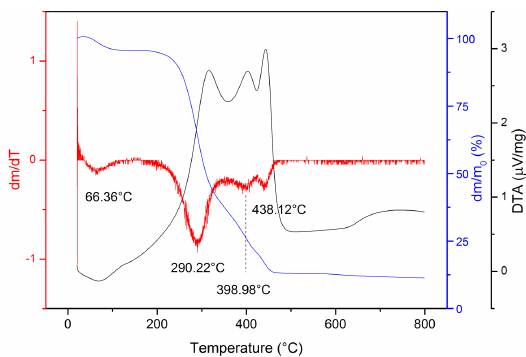
Figure 5. TG/DTG/DTA curves of UV7 BF. Bibliographic source: Author.